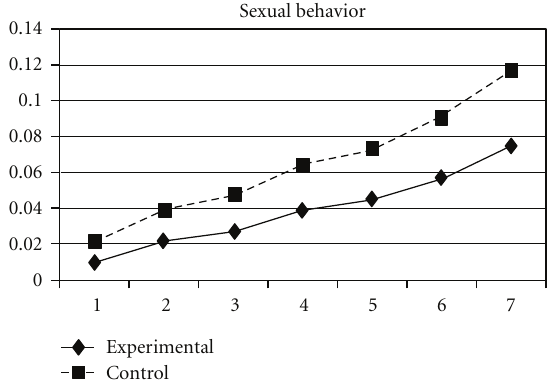
Figure 2: Growth trajectories of the experimental group (all par- ticipants) and control group using the item score of having sexual behavior with others as the outcome